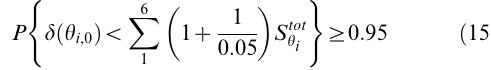
Figure 11. Model-predicted standard deviation in the treat- ment response over treatment period. A. Standard deviation for leukocytes response as a function of time, B. Standard deviation for D MCV. Variability explained by the models is in line with the pattern observed during 6-MP treatment.